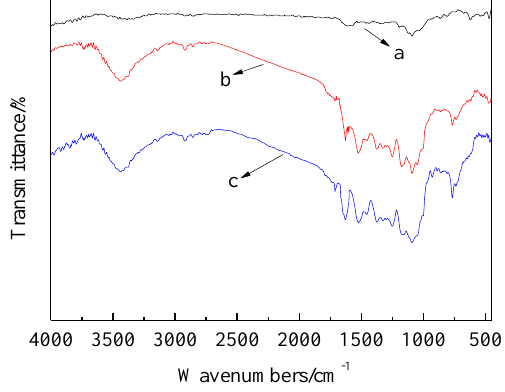
Figure 11. FTIR spectra of: ( a ) chalcopyrite; ( b ) chalcopyrite + BIPECTC; ( c ) chalcopyrite + BMIPECTC.